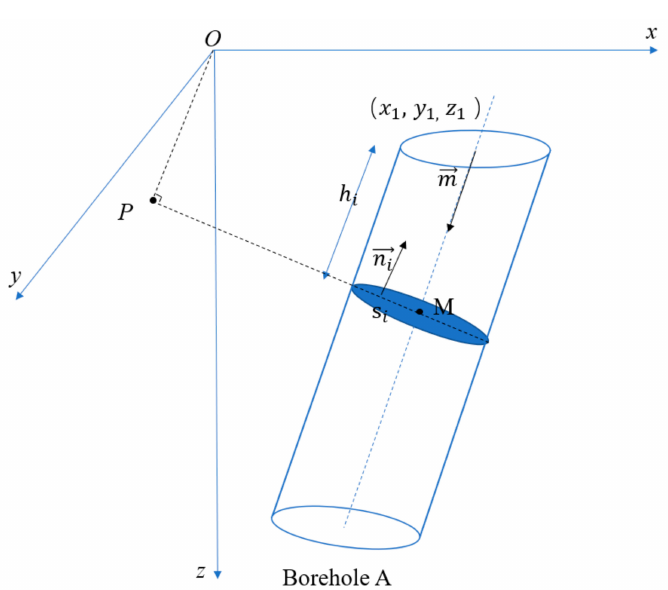
Figure 4. Coordinate points corresponding to the structural